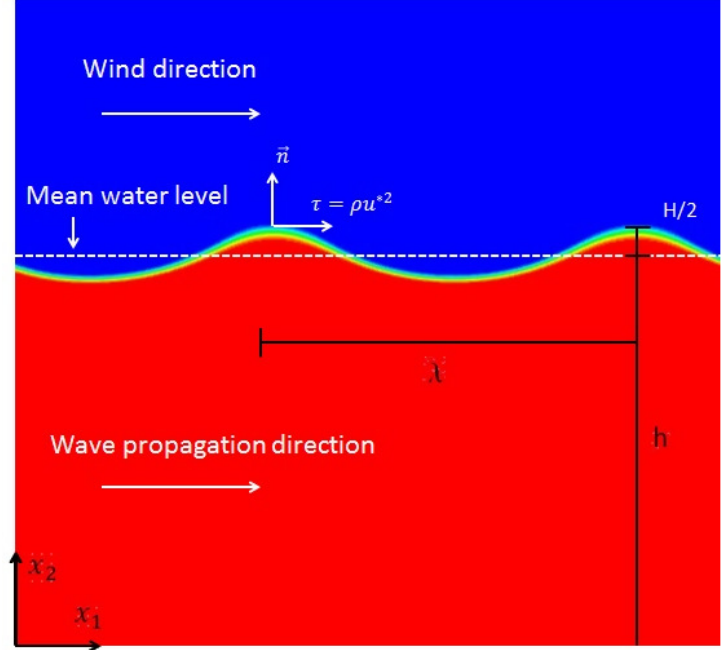
Figure 2. Details of multi-phase wave simulation. The areas colored in red represent cells with water phase (i.e., α w = 1 in Equation (7)) and areas colored in blue represent cells with air phase (i.e., α w = 0). Note that the air–water interface is characterized by a thickness associated with the Volume Of Fluid (VOF)